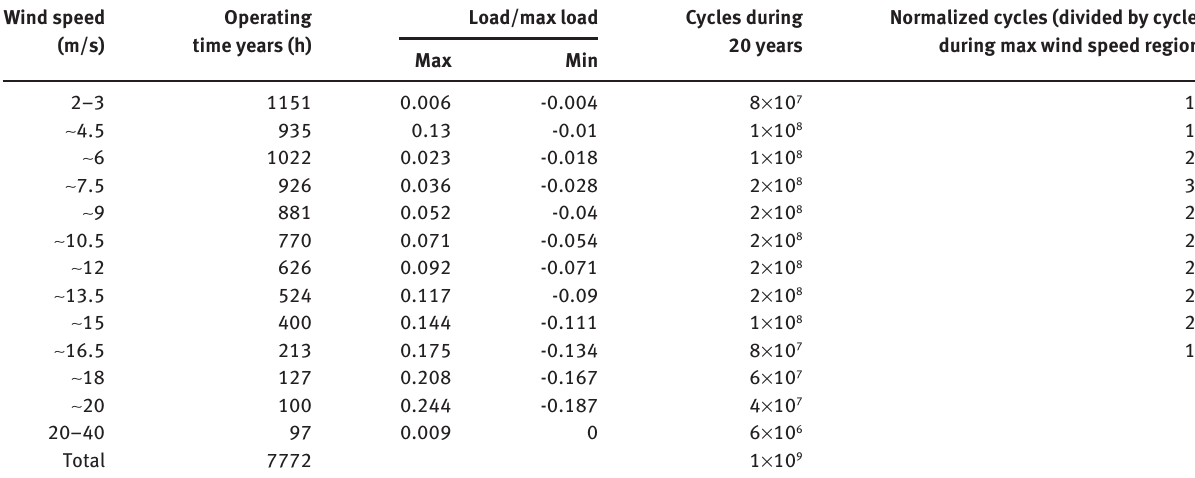
Table 6 Load spectrum obtained by the aerodynamic design program and the wind data measured at Ganyeoam, Yeosu, Jeollanam-do in Korea.